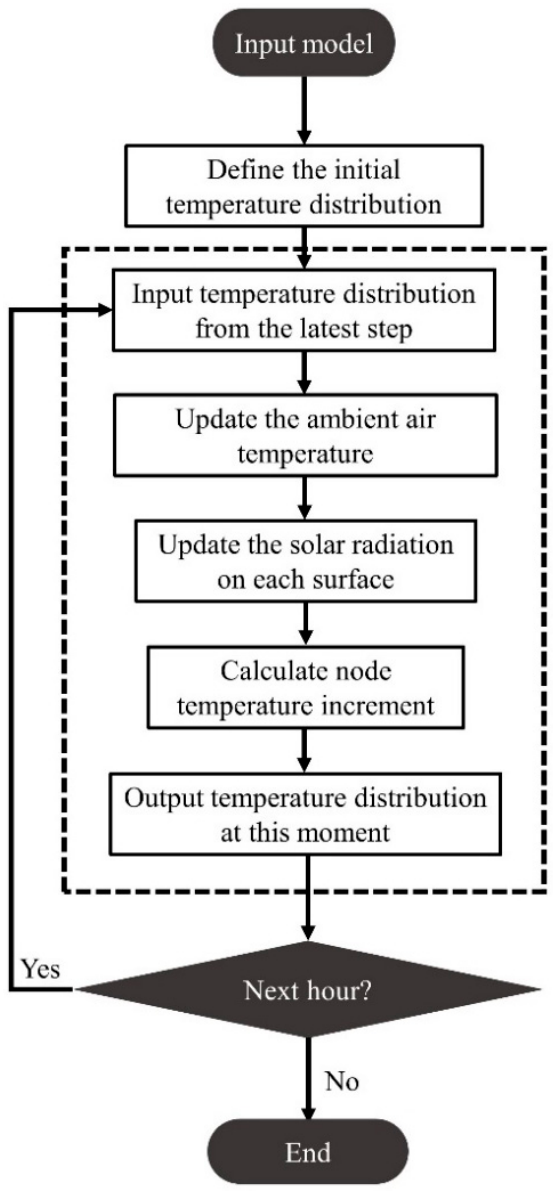
Figure 10. Numerical simulation process for the truss aqueduct under solar radiation.